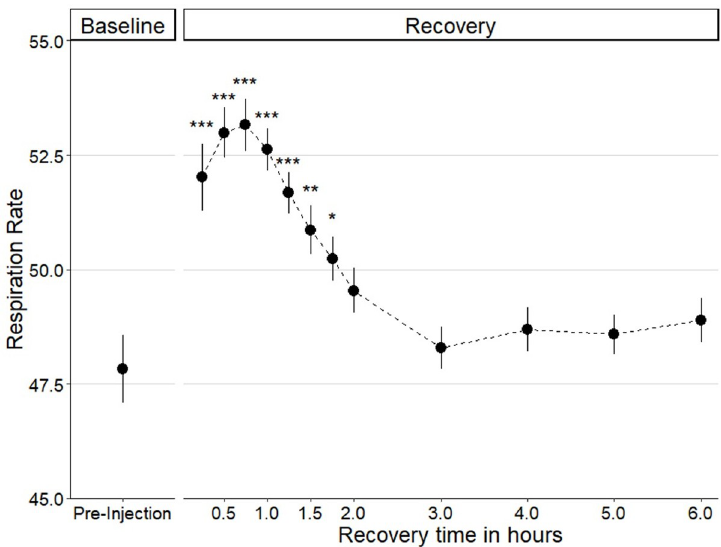
Fig 5. Average recovery curve of respiration rate following transcranial brain injections ( N = 62). Respiration (opercular beats per 20 seconds) rate returned to baseline levels by two hours post-injection and remained stable following the surgery. Mean ± SE � p � 0.05; �� p � 0.01; ��� p � 0.001.